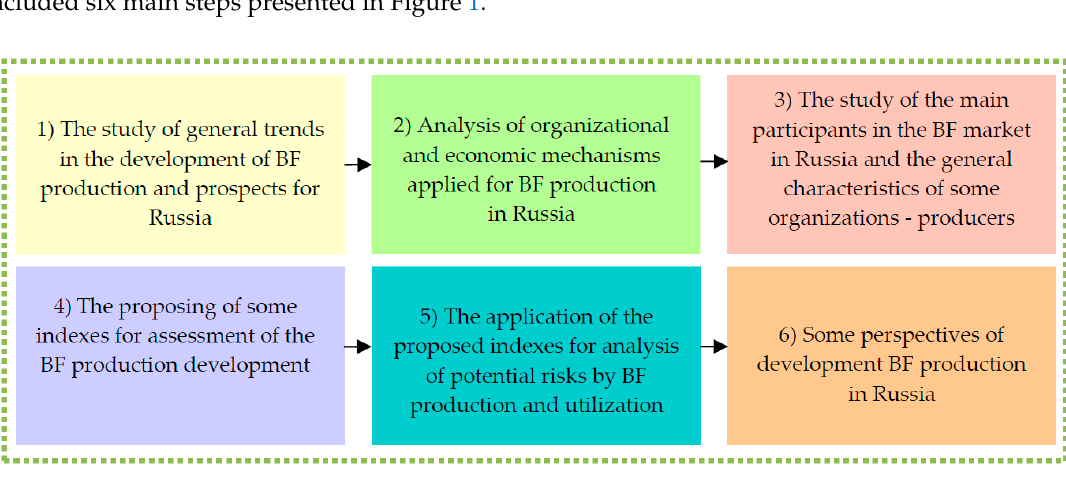
Figure 1. General study algorithm.